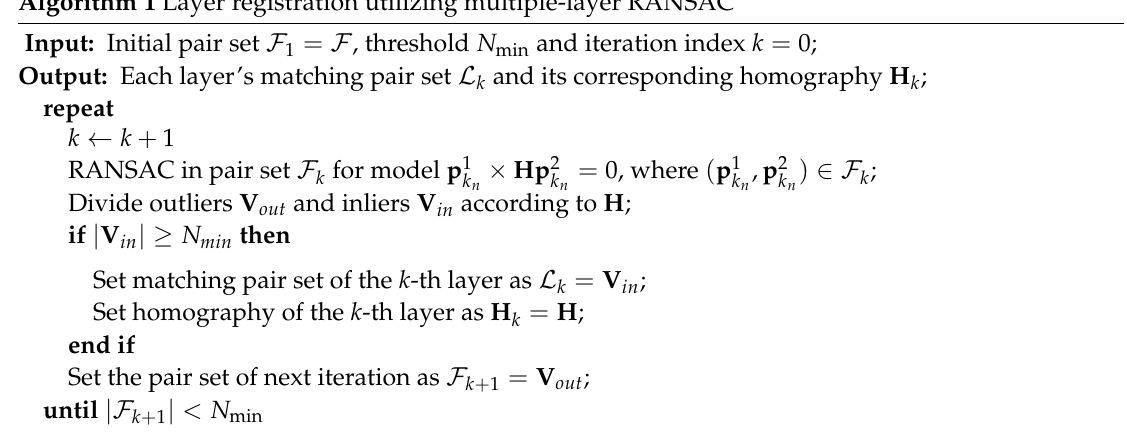
Algorithm 1 Layer registration utilizing multiple-layer